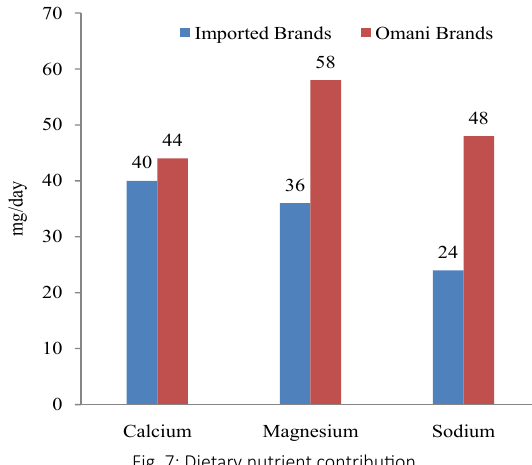
Fig. 7: Dietary nutrient contribution